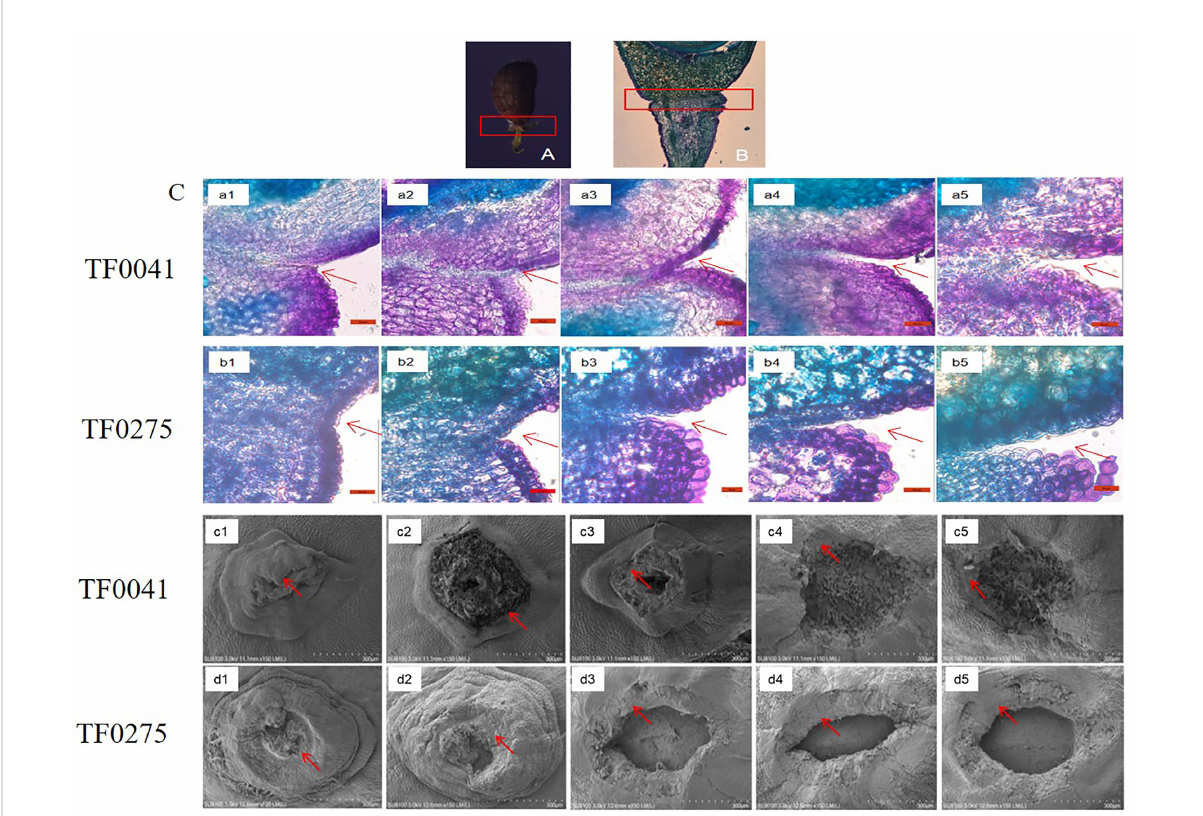
FIGURE 3 Histological analysis of the abscission zone. (A, B) Seed stalk histological structure and abscission layer position in the seed stalk. (C) a1 and b1 , a2 and b2 , a3 and b3 , a4 and b4 , and a5 and b5 show the longitudinal sections across the abscission zones of TF0041 and TF0275 at 7, 14, 21, 28, and 35 days after fl owering (DAF), respectively. c1 and d1 , c2 and d2 , c3 and d3 , c4 and d4 , and c5 and d5 display the scanning electron microscopy photos of the seed stalk junctions after detachment of the seeds in TF0041 and TF0275 at 7, 14, 21, 28, and 35 DAF, respectively. The red arrow indicates the location of the abscission layer. The red frame in (A) and (B) denotes the abscission zone. Bar , 50 m m in a1 – a5 and b1 – b5 and 300 m m in c1 – c5 and d1 – d5